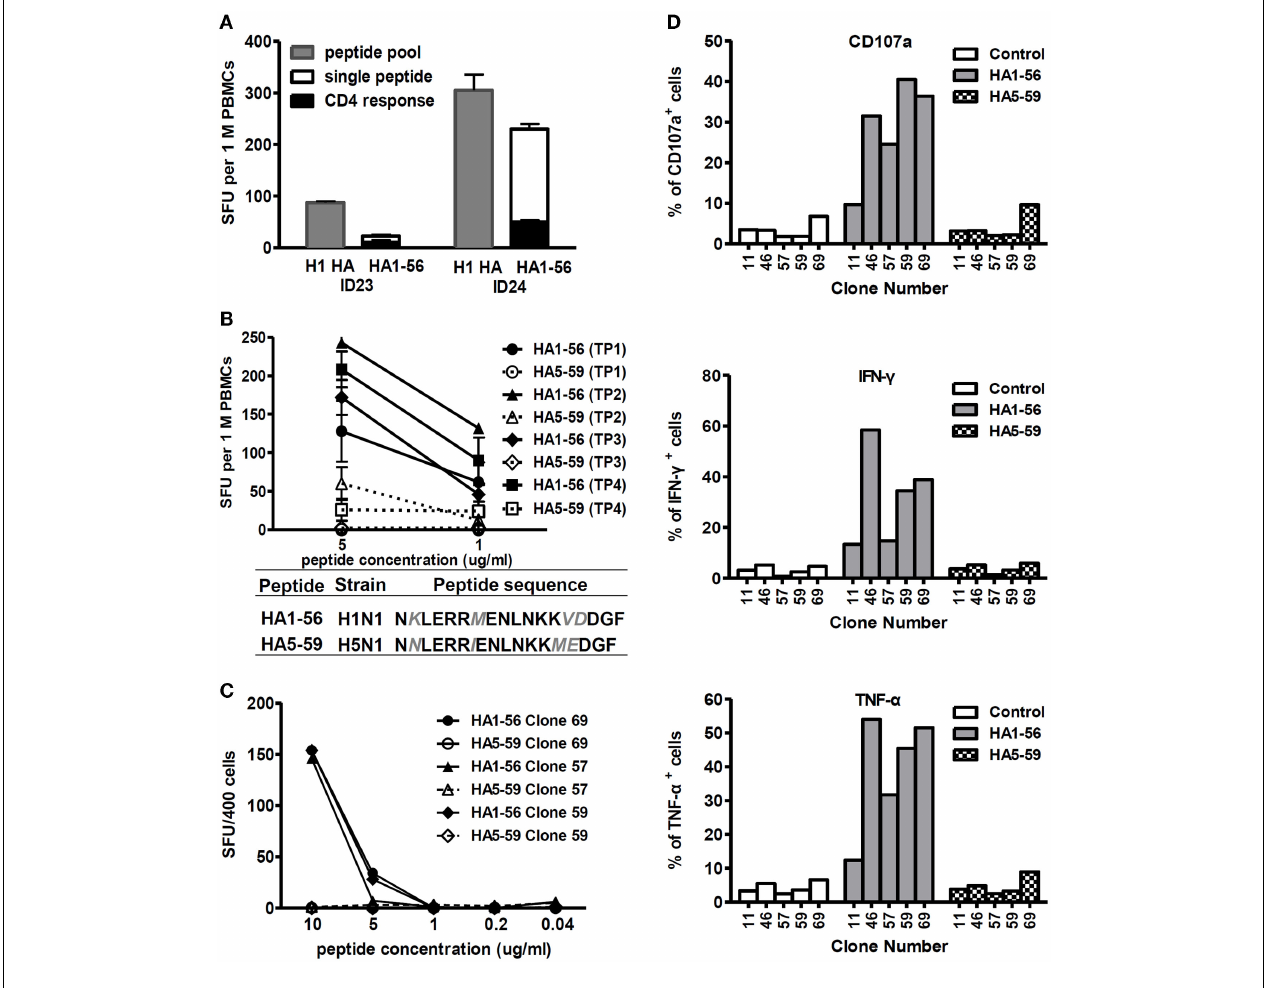
replicates. Amino acids differing between HA1-56 and HA5-59 are shown in gray italics. (C,D) Cross-recognition of peptides HA1-56 and HA5-59 by T cell clones generated from study subject ID24. The cross-reactivity of T cell clones was assessed by IFN- γ ELISPOT using titrated peptides (C) , degranulation (CD107a expression), and intracellular TNF α and IFN- γ production (D)